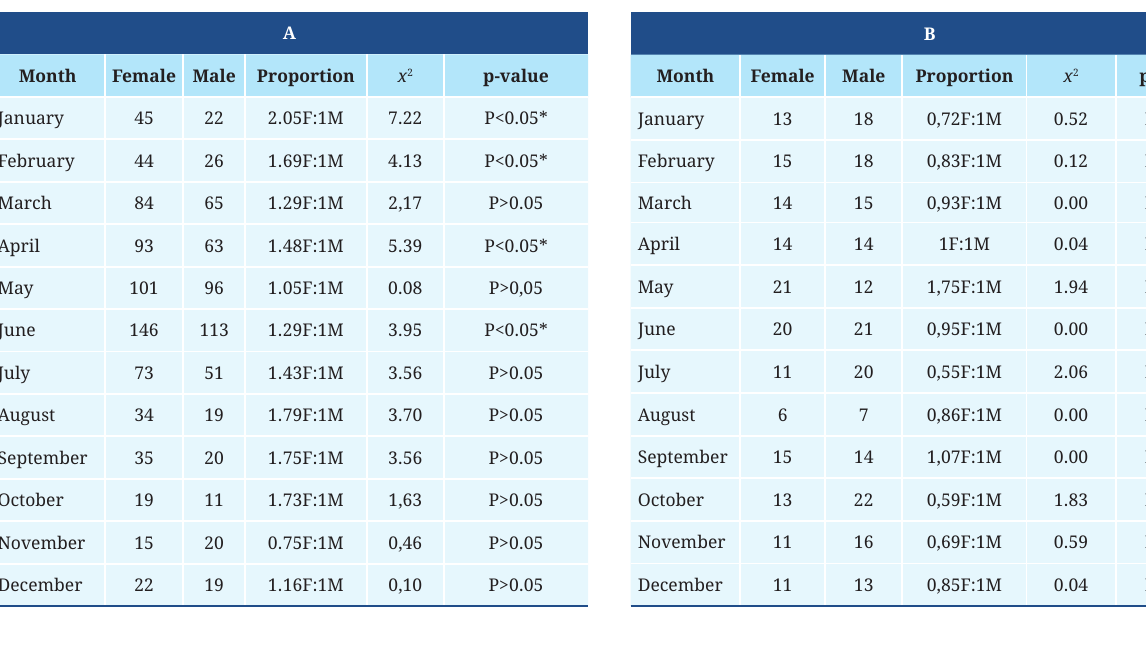
TABLE 1 | Monthly distribution of sex ratio and chi-square ( x 2 ) of Alopias pelagicus ( A ) and A. superciliosus ( B ). *Present significant differences.